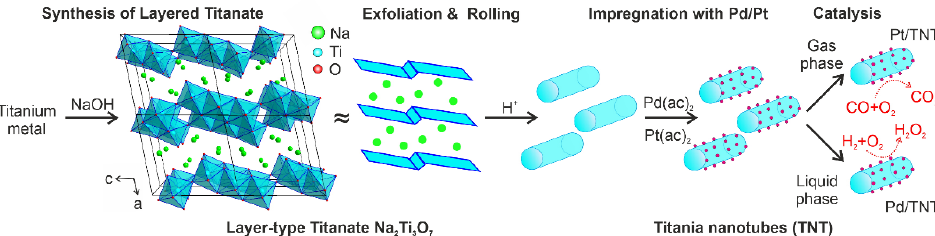
Figure 1. Scheme of the synthesis strategy starting from the oxidation of titanium metal via the formation and exfoliation of the layer-type titanate Na 2 Ti 3 O 7 to TNTs as well as the impregnation with Pd and Pt to obtain Pd/TNTs and Pt/TNTs.